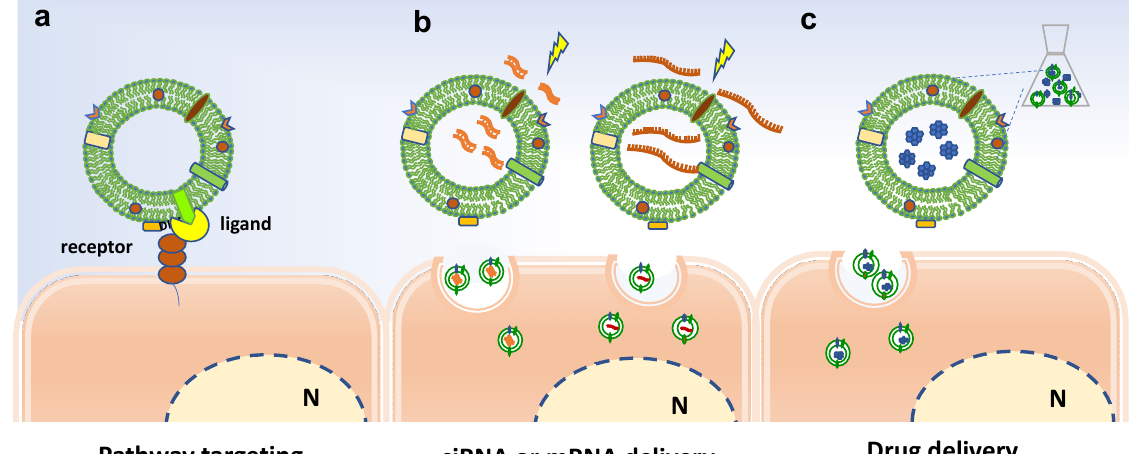
Figure 5. Bioengineering approaches to increase efficacy of plant-derived vesicles for therapeutic purposes. Schematic representation on current strategies and possible approaches for surface-functionalization and loading of extracellular vesicles. ( a ) Potential receptor binding ligands may target PDVs to specific cell population. ( b ) Electroporation to load miRNA and siRNA in PDVs. ( c ) Passive loading of bioactive molecules in PDVs. N indicates the nucleus.